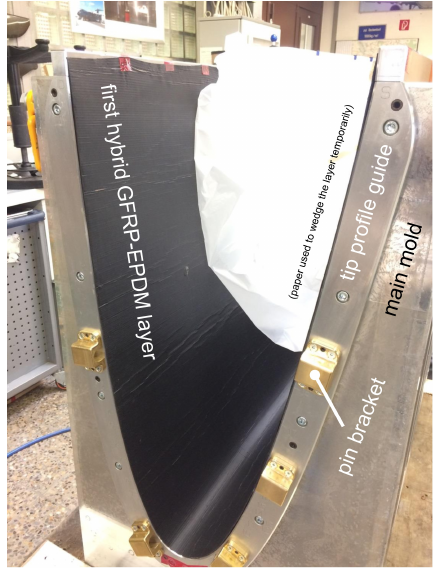
Figure 7. The first hybrid glass-fiber-reinforced plastic (GFRP) - ethylene propylene diene monomer (EPDM) layer laid in the